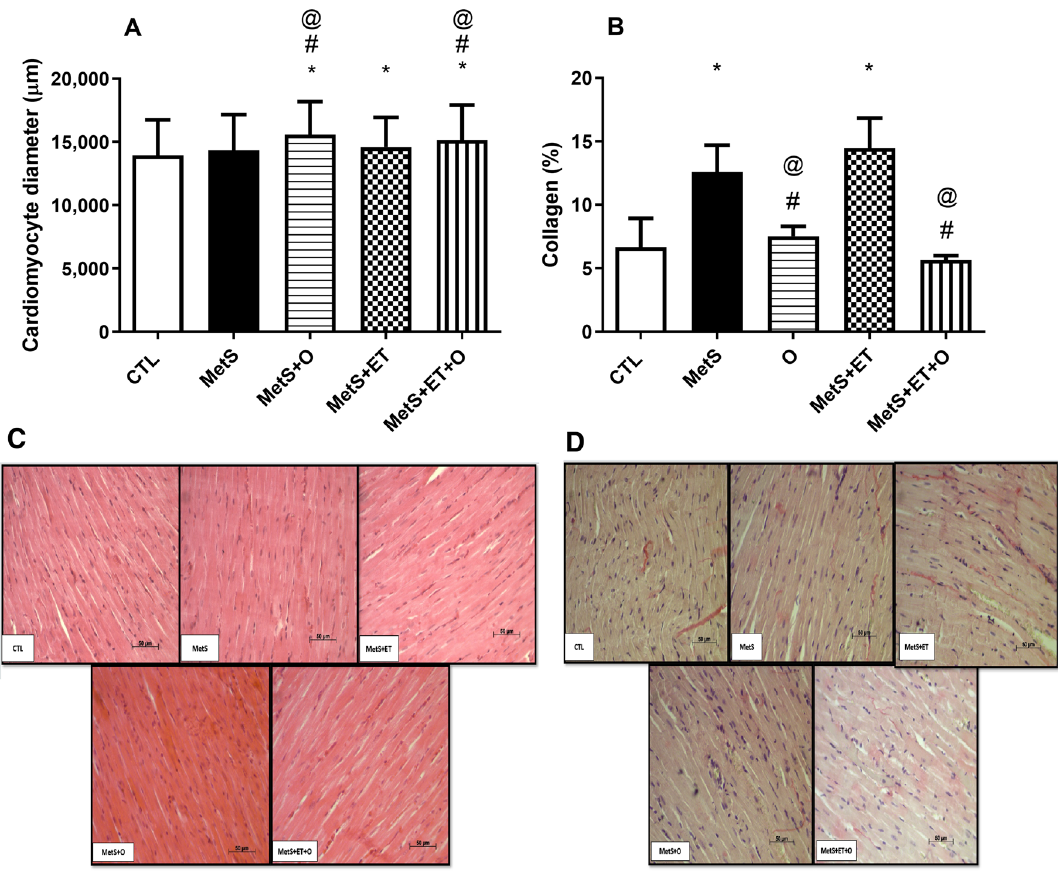
Figure 3. Histological analysis of the ventricles using hematoxylin and cosin staining technique of the groups. ( a ) Cardiomyocyte diameter: ( b ) Fraction of collagen in cardiac tissue. ( c ) Representative images of sections stained with hematoxylin and cosin. ( d ) Representative images of picrosirus-stained section. CTL–Control, MetS–Metabolic Syndrome, MetS+O–Metabolic Syndrome and Okra, MetS+ET– Metabolic Syndrome and Exercise Training, MetS+ET+O–Metabolic Syndrome and Exercise Training and Okra. *Different from CTL, #Different from MetS, @Differenct from MetS+ET, p ≤